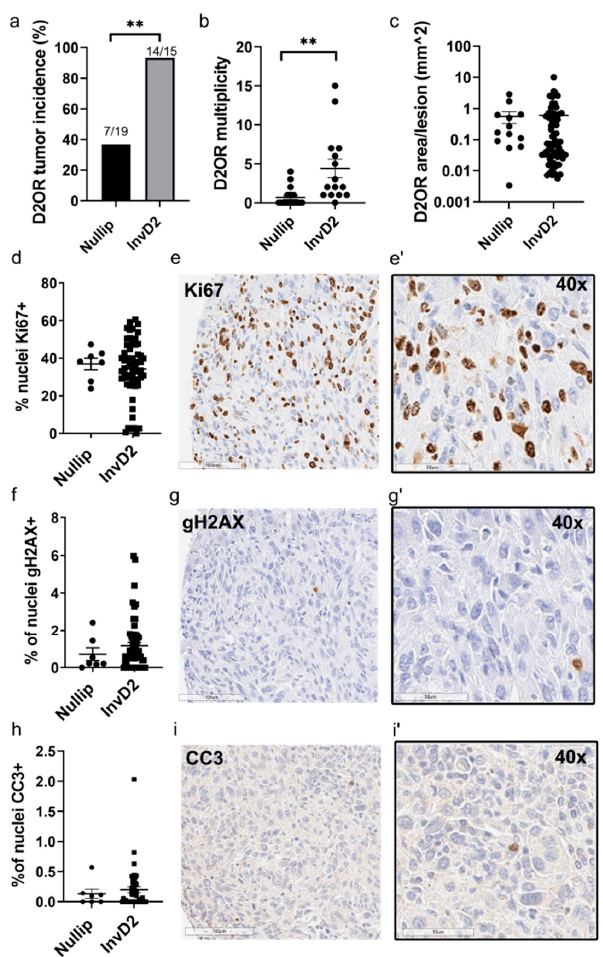
Figure 1. Increased metastasis in involution hosts does not associate with enhanced tumor growth. ( a ) Incidence of D2OR liver metastases in nulliparous (nullip, n = 19) and involution day 2 (InvD2, n = 15) mice, n = 3 independent studies; Two-sided Fisher’s exact test; ( b ) Number of metastases (i.e., multiplicity) per mouse in nullip ( n = 19) and InvD2 ( n = 15) groups; Two-tailed T test; ( c ) Area per tumor in nullip ( n = 13 tumors) and InvD2 ( n = 66 tumors) hosts; IHC quantification of percent of tumor nuclei positive for ( d ) Ki67 in nullip ( n = 7 tumors) and InvD2 ( n = 57 tumors); ( f ) γ H2AX in nullip ( n = 7 tumors) and InvD2 ( n = 58 tumors), and ( h ) cleaved caspase 3 (CC3) in nullip ( n = 7) and InvD2 ( n = 48); Representative IHC images at low and high magnification of Ki67 ( e , e’ ), γ H2AX ( g , g’ ), and CC3 ( i , i’ ) stains. ** p <